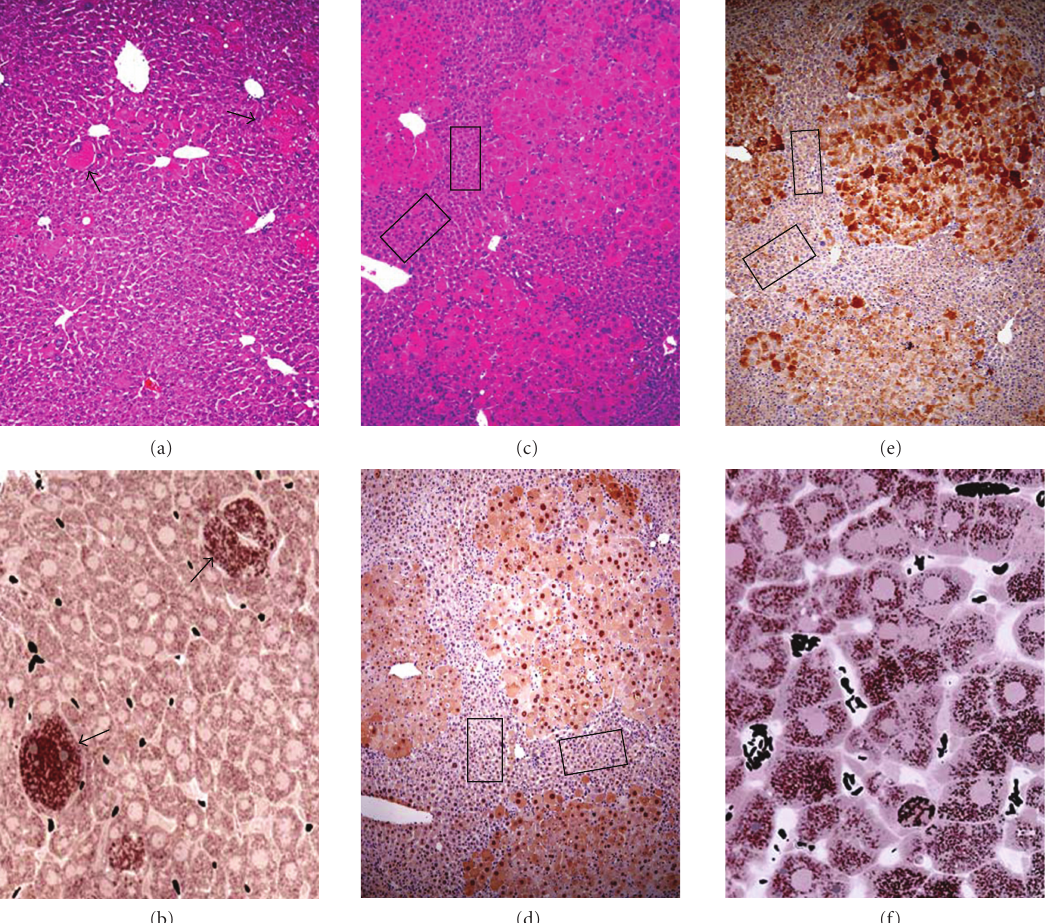
Figure 3: E ff ects of Med1 and PRIP deletion on PPAR α ligand-induced pleiotropic responses in liver. Med1 Δ Liv mice treated with Wy-14,643 (0.125% wt/wt) for 2 weeks (a, b) show an occasional hepatocyte that escaped Alb-Cre mediated deletion of Med1 floxed alleles. These Med1 positive hepatocytes respond to the peroxisome proliferative e ff ects of PPAR α -ligand (arrows indicate to Med1 + / + cells with numerous peroxisomes) but not the majority of Med1 − / − hepatocytes. Chronic treatment of Med1 Δ Liv mice with 0.02% Wy-14,643 for 5 months (c–e) results in clonal expansion of residual Med1 fl / fl cells as demonstrated by H&E staining (c). In contrast, the adjacent hepatocyte lacking Med1 are generally smaller than normal hepatocytes (see boxed area in c). Immunohistochemical localization of Med1 reveals that expanding colonies of large hepatocytes are Med1 positive (nuclear Med1 in panel d). These cells also show abundant cytoplasmic expression of L-PBE, the second enzyme of the peroxisomal fatty acid β -oxidation system (panel e), whereas the smaller Med1 null hepatocytes ( boxed areas ) fail to show L-PBE induction (panel e). Disruption of coactivator PRIP in hepatocytes does not interfere with PPAR α ligand-induced peroxisome proliferation as evidenced by the abundant catalase positive peroxisomes (brown dots) in all hepatocytes (panel f). Compare this panel (f) with panel (b) in which only an occasional Med1 + / + cell responds to PPAR α